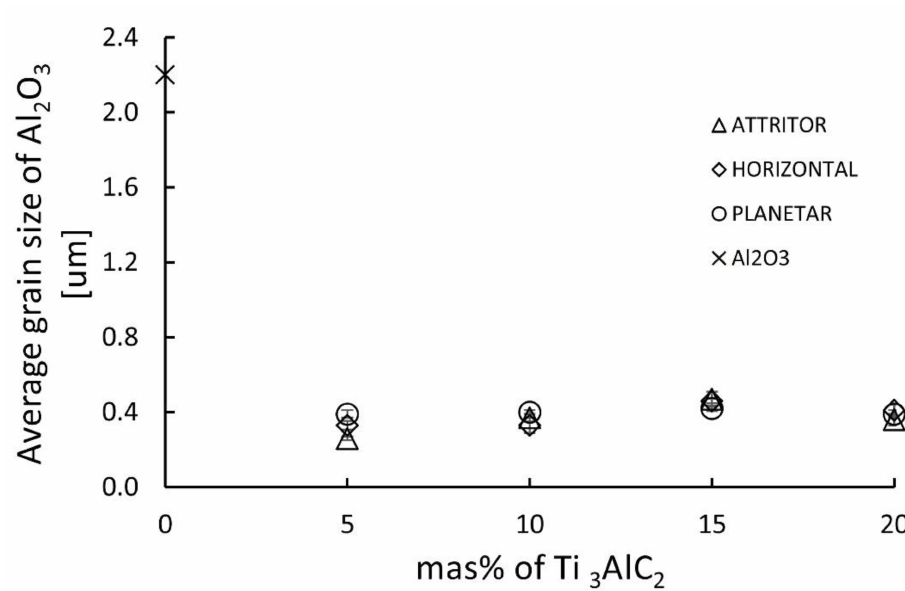
Figure 7. Average grain size of alumina in Al 2 O 3 -Ti 3 AlC 2 composites.